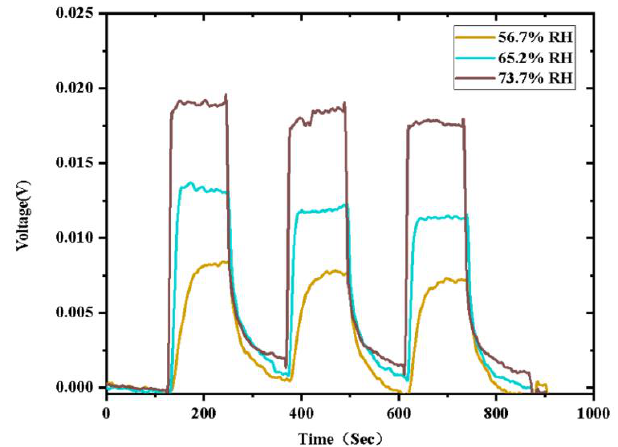
Figure 7. Repeated response of humidity sensor in different water vapor concentrations. The response change of the sensor in different concentrations is shown in Figure 8.